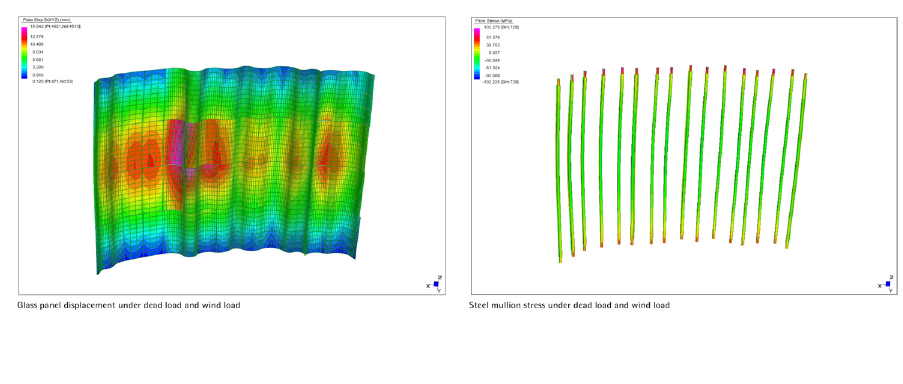
Figure 22a, b: Global Stress Analysis in Glass Panels, Stress Analysis in Suspended Mullions.